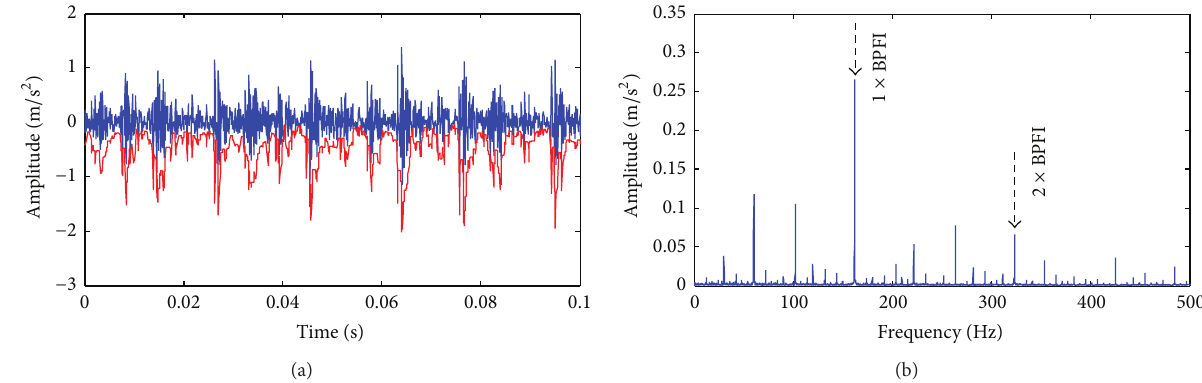
Figure 10: (a) Results of morphological operation open-close gradient; (b) frequency spectrum of (a).